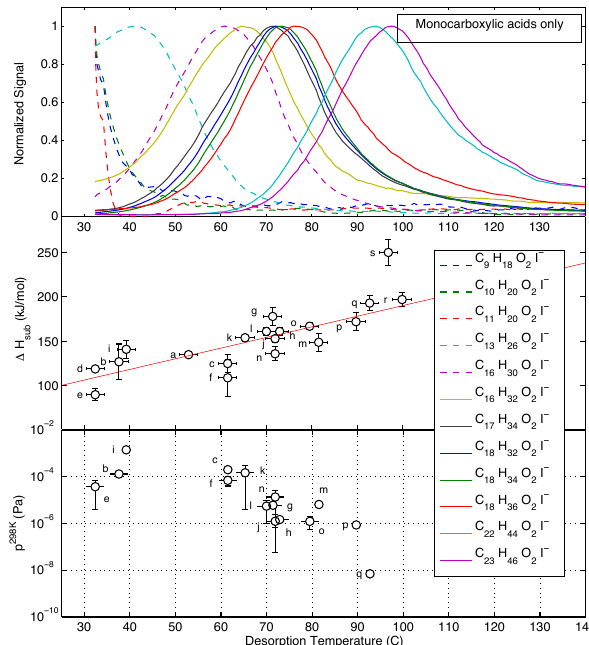
Fig. 6. Top: thermograms from a series of mono carboxylic acids are shown as detected by a FIGAERO-HRToF-CIMS operating in the field employing Iodide adduct ionization. The acids were part of a single mixture of several organic compounds that was deposited manually via a micro-syringe onto the FIGAERO filter, and then the filter was subjected to a standard thermal desorption. The series of acids each desorb with a single signal maximum (mode), signify- ing little contamination from other ions (see text). Middle: 1H sub values for compounds in the deposited mixture from the literature (open symbols) or estimated here using group contribution methods (dots) are plotted versus the temperature at which the compound’s signal reached a maximum in the desorption ( T max , see text). Let- ters correspond to the identifier (ID) listed in Table 2. Bottom: lit- erature vapor pressures over the solid scattered with maximum des- orption temperature. The relationship is less clear than enthalpy of sublimation likely resulting from the larger relative uncertainties in the measured vapor